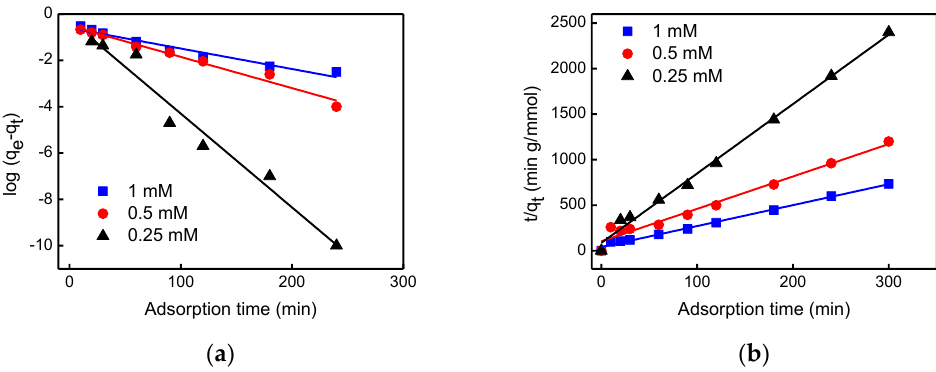
Figure 12. Linear fitting for ( a ) pseudo-first-order kinetic model and ( b ) pseudo-second-order kinetic model with various adsorption times. [AERs] = 2 g/L; [EDTA] = 0.25 ( ▲ ), 0.5 (●), and 1 ( ■ ) mM; pH = 7. Table 1. Adsorption kinetic parameters of the adsorption of ethylenediaminetetraacetic acid (EDTA) on anion-exchange resins (AERs) from EDTA/Cs solution. Pseudo-first-order